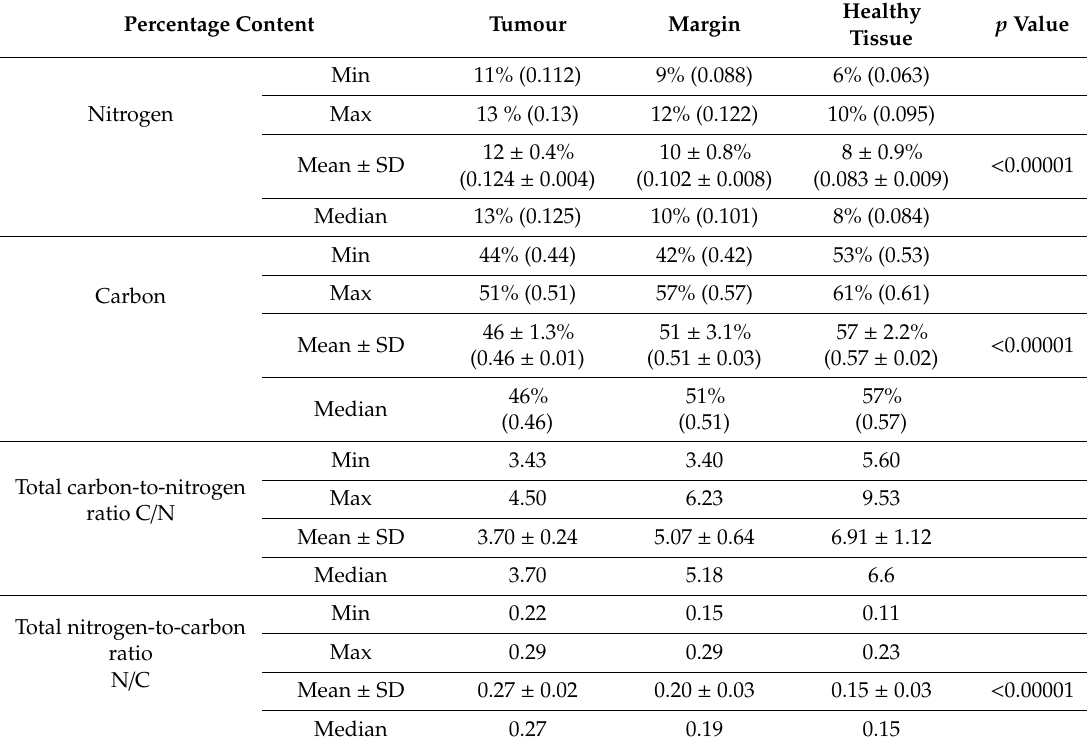
Table 2. Percentage content of nitrogen and carbon in tumour, margin and healthy tissues and total carbon-to-nitrogen ratio C / N and nitrogen-to-carbon ratio N /